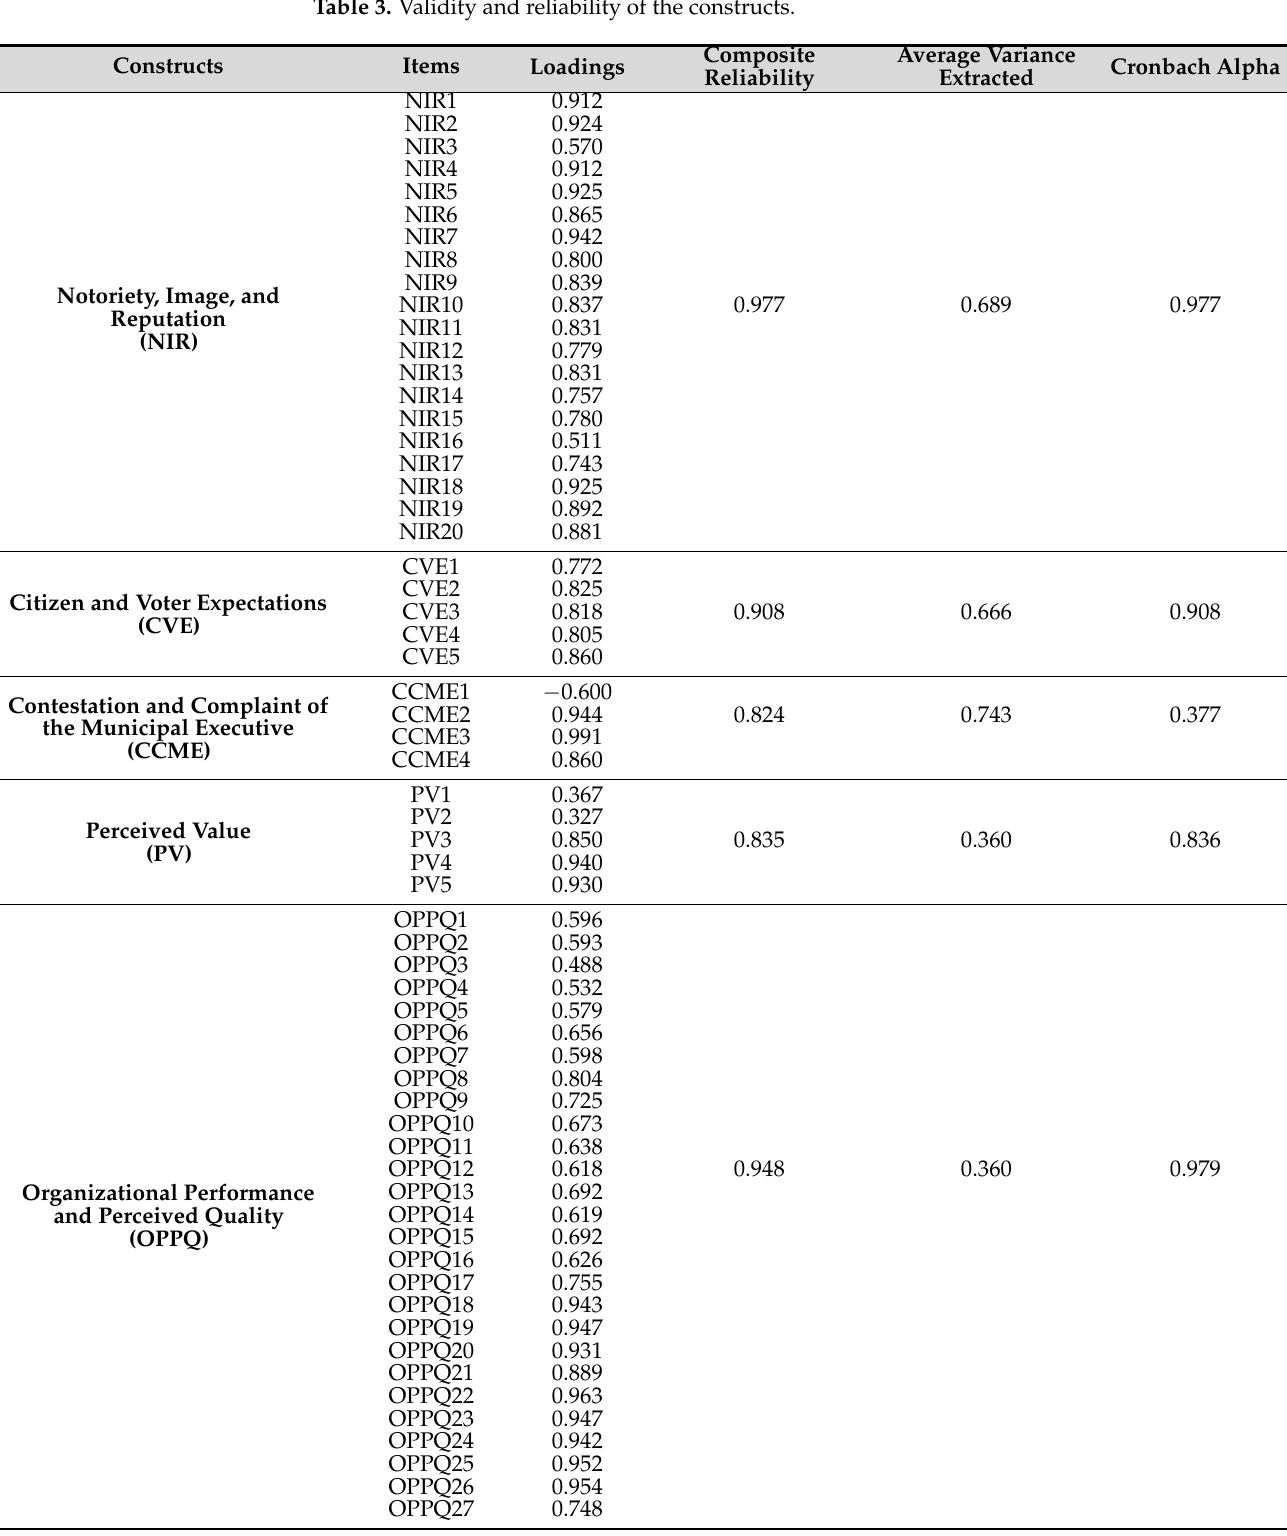
Table 3. Validity and reliability of the